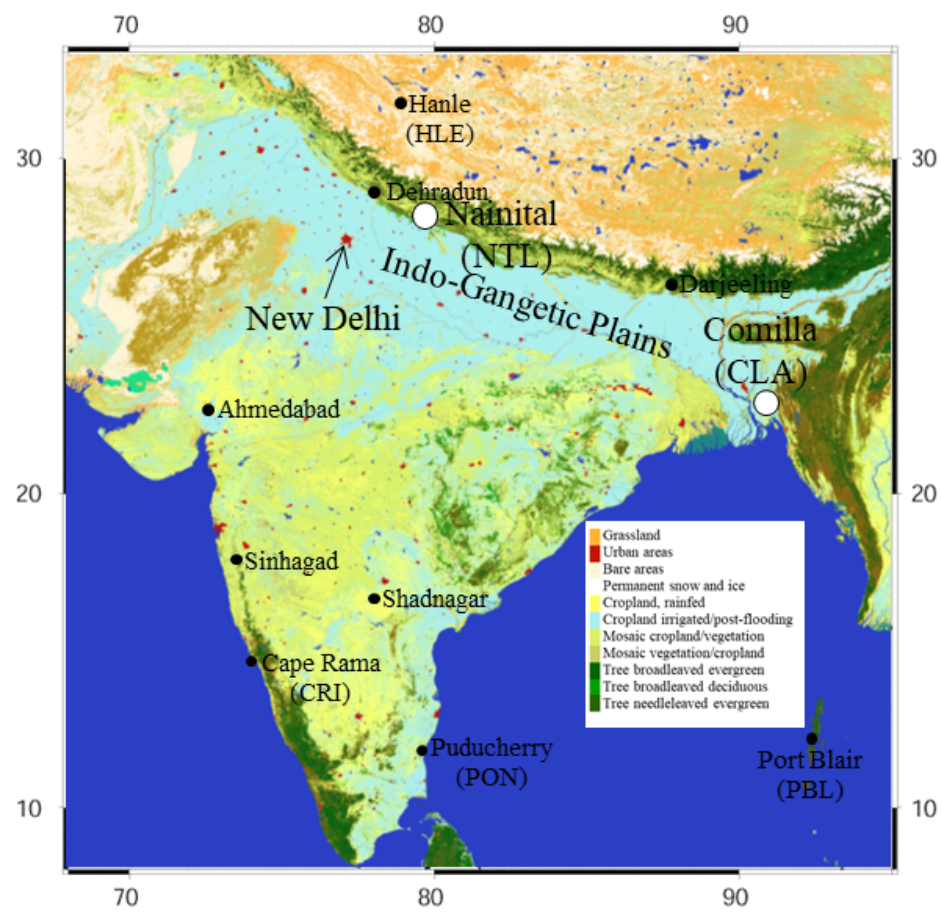
Figure 1. Locations of Nainital (NTL), India (29.36 ◦ N, 79.46 ◦ E; 1940ma.s.l.), Comilla (CLA), Bangladesh (23.43 ◦ N, 91.18 ◦ E; 30ma.s.l.), and other Indian sites for greenhouse gas (GHG) observation (Bhattacharya et al., 2009; Ganesan et al., 2013; Sharma et al., 2013; Tiwari et al., 2014; Lie et al., 2015; Sreenivas et al., 2016; Chandra et al., 2016) and showing land cover around the South Asia region (Arino et al.,